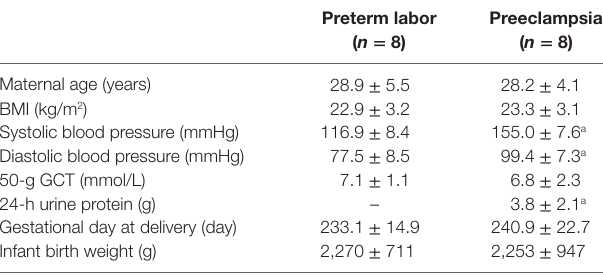
Table 1 | The clinical characteristics of the pregnant women enrolled in this